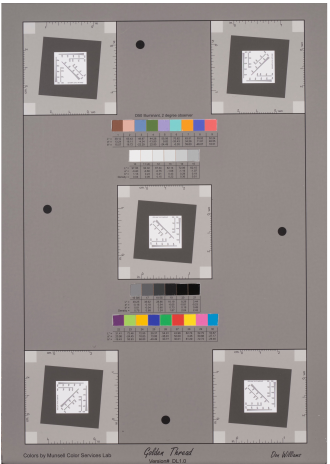
Figure 1. DICE device level target that includes various features to measure image quality and performance of digital imaging